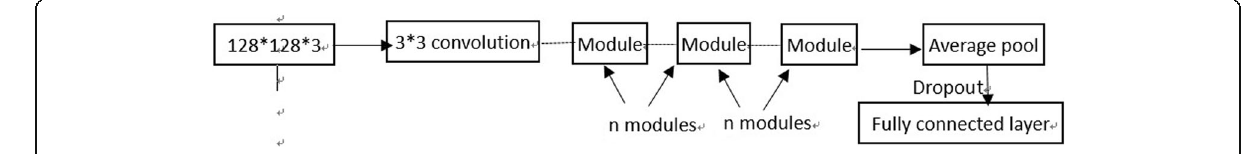
Fig. 7 Residual neural network complete network structure